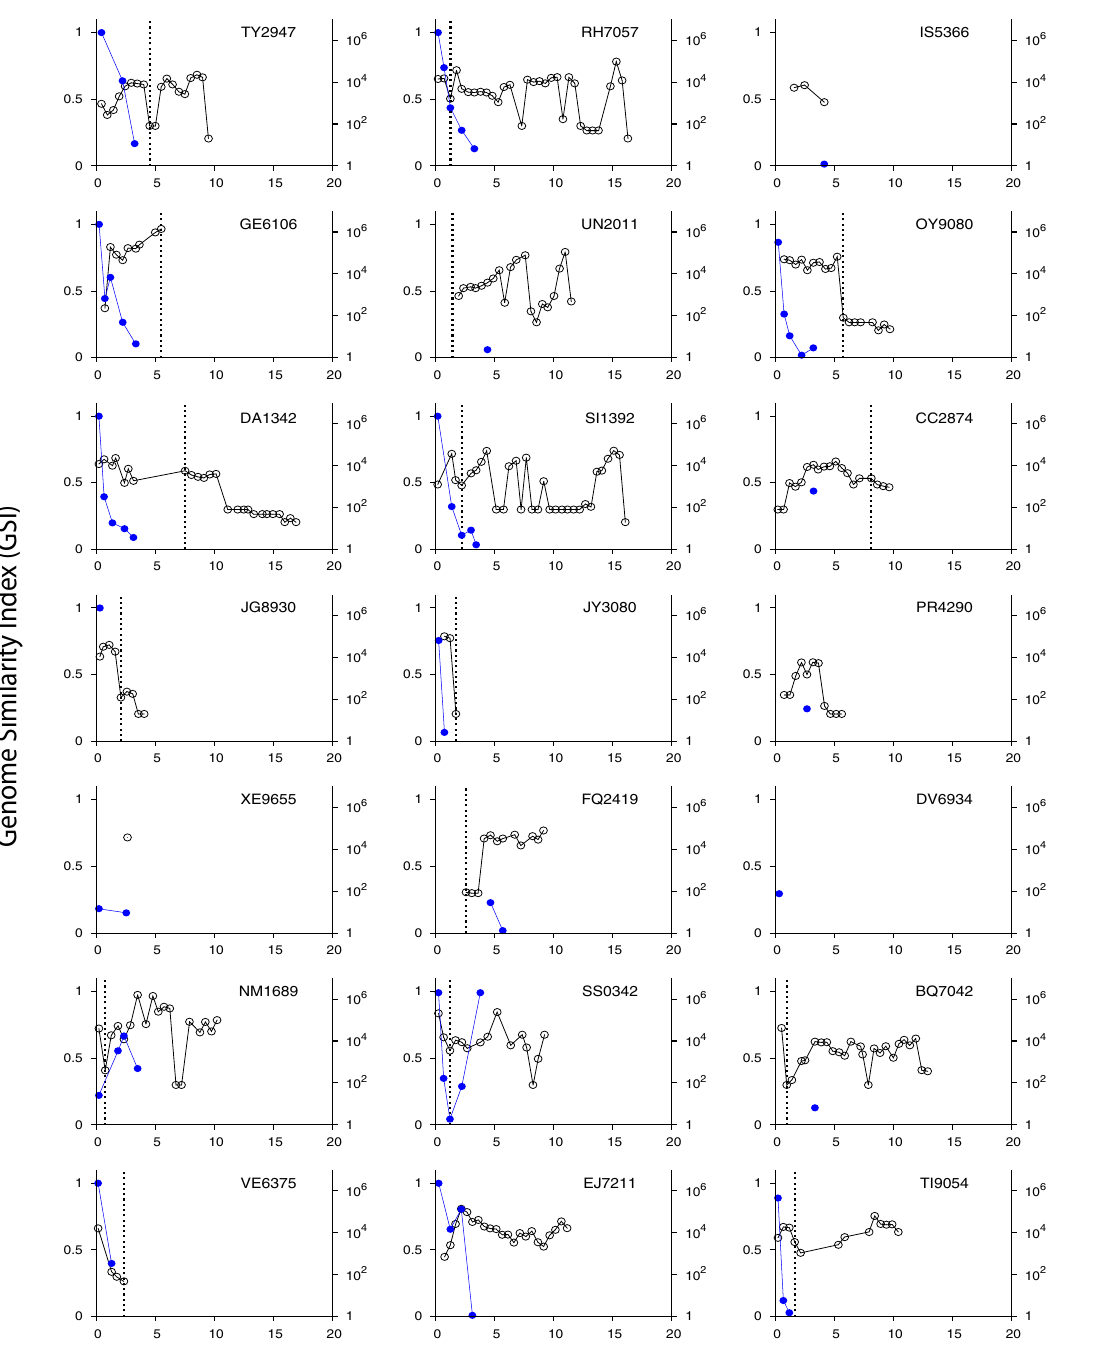
Figure 6. Genomic incidence assay biomarker and viral load dynamics of 21 WIHS longitudinally followed subjects. Each subject’s GSI is represented by blue filled dots and viral load by black empty dots. The GSI was measured from eight or more HIV-1 envelope gene segments (HXB2 7134-7499) from each specimen using Eq. (1). Years since infection was estimated by taking the mid-point between each subject’s last HIV negative date and first HIV positve date, and each subsequent sample collection date. The dotted black vertical line indicates ART initiation. Of 14 longitudinally sequenced subjects all except two subjects (NM1689 and SS0342) showed GSI decline over time as